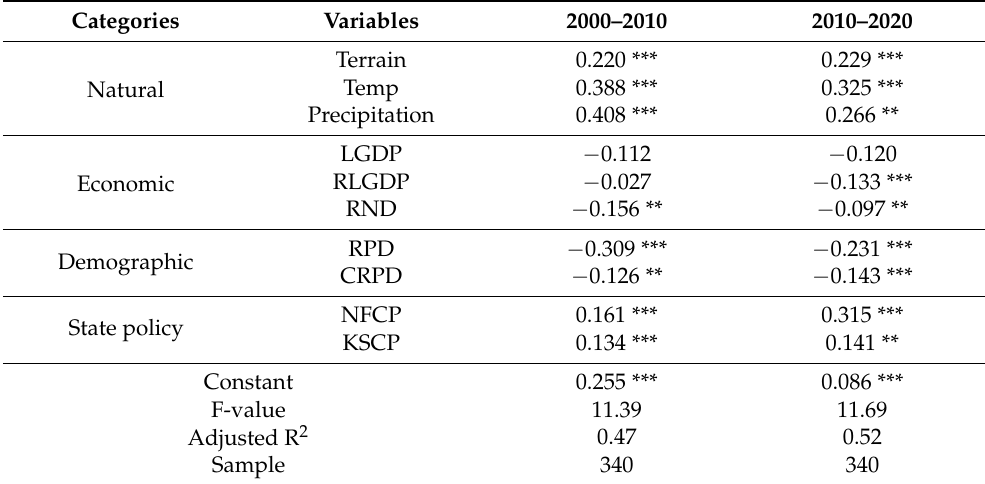
Table 4. The regression results for all